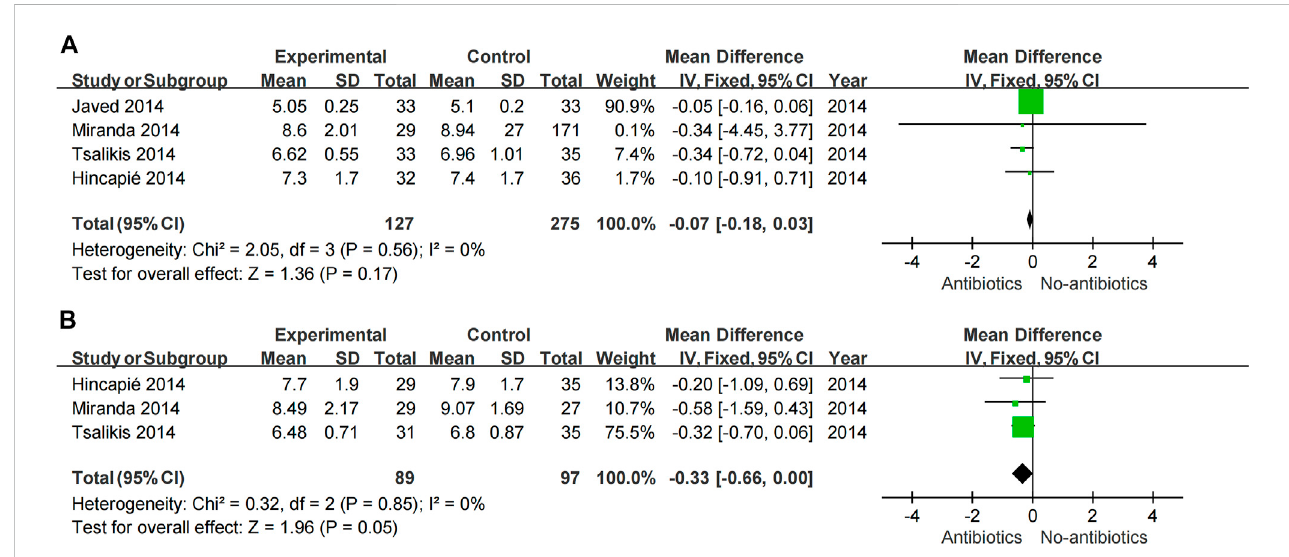
FIGURE 5 Forest plot of the effect of systemic adjuvant antibiotics on HbA1c. (A) Changes in HbA1c at 3 months. (B) Changes in HbA1c at 6